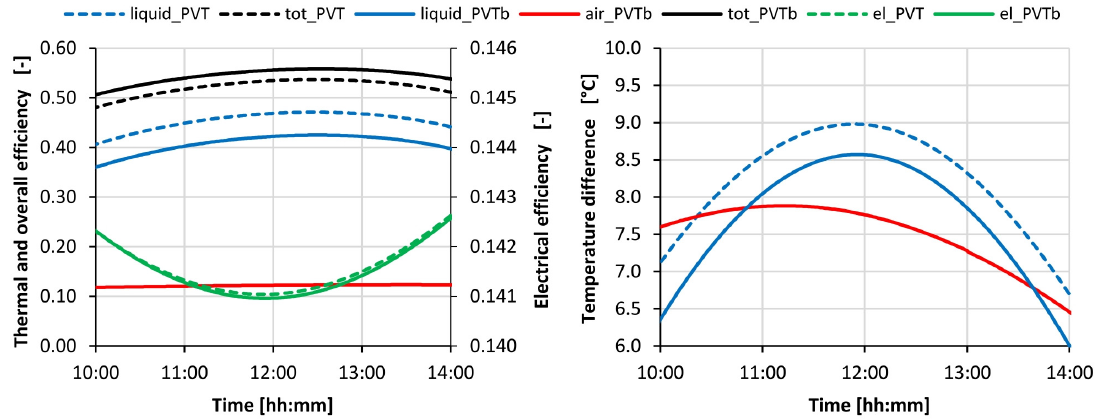
Figure 10. Comparison between the PVT e PVTb performances during a summer day. The electrical, thermal, and overall efficiencies are depicted on the left side; the dif- ference between the inlet and outlet temperatures at the air side (only for PVTb) and the liquid side is depicted at the right